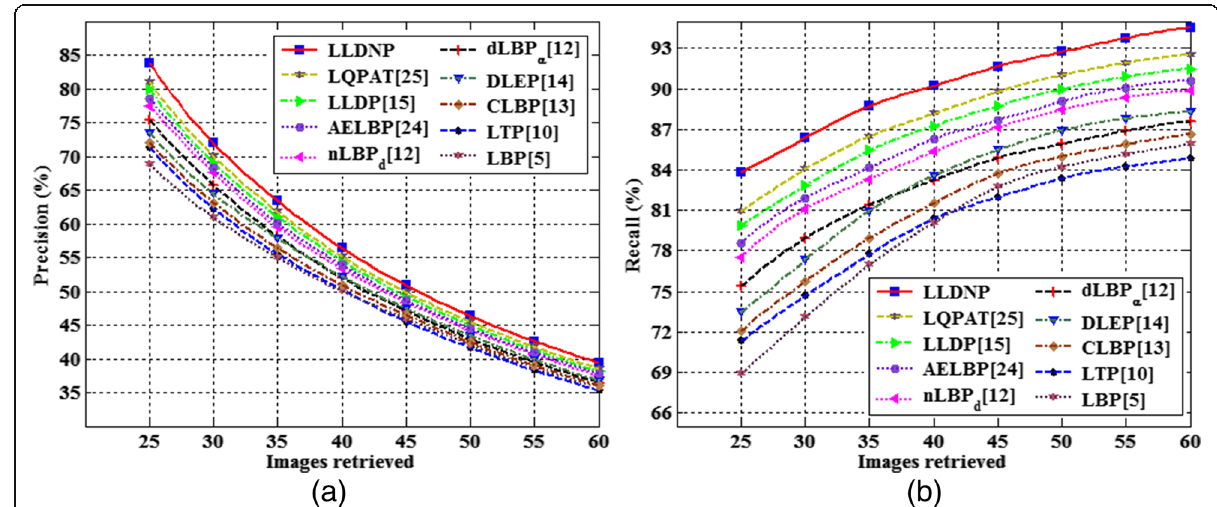
Fig. 6 Comparison of LLDNP with other existing methods in terms of a precision and b recall on Brodatz database. The performance of existing methods and proposed LLDNP in terms of precision and recall is analyzed. Initially, 25 images are retrieved from the database and then increased by 5 and finally retrieved up to 60 images. The proposed LLDNP shows improved performance than the other existing methods on Brodatz